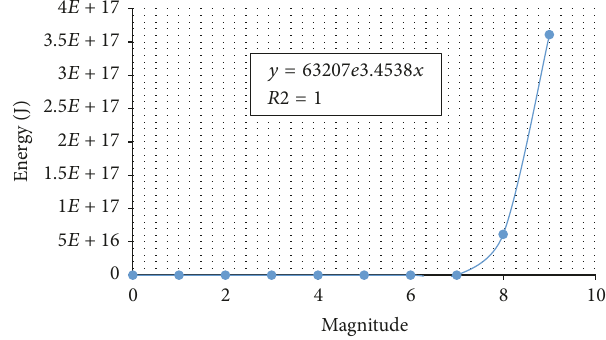
Figure 8: Energy versus